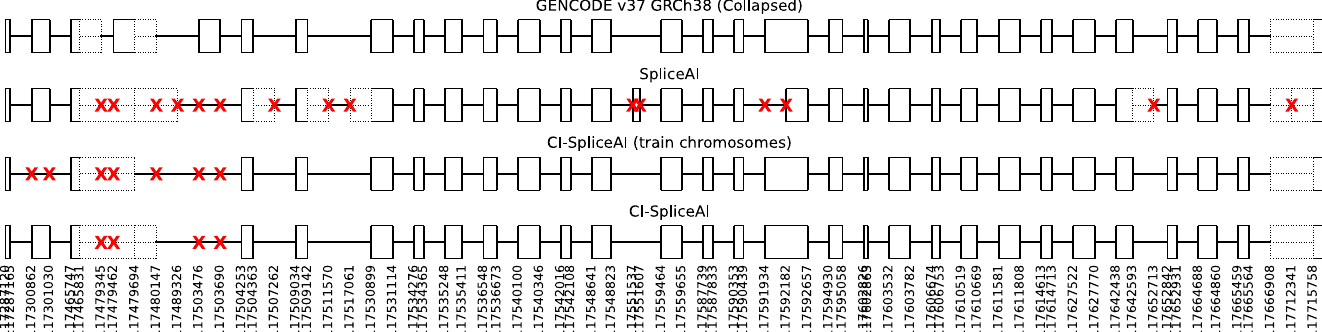
Fig 3. Predictions of splice sites in CFTR in comparison to our ground truth from GENCODE. Mispredictions are marked with a red X. The original SpliceAI algorithm misses one exon, adds one extra, and mispredicts 15 sites in total. When trained on collapsed the curated GENCODE sites (train chromosomes), CI-SpliceAI misses two exons, does not add any extra exons, and mispredicts 7 sites in total. When trained on the collapsed isoform data and all chromosomes (which includes this gene), one missing exon is detected correctly and the overall error decreases to 4 mispredicted sites in